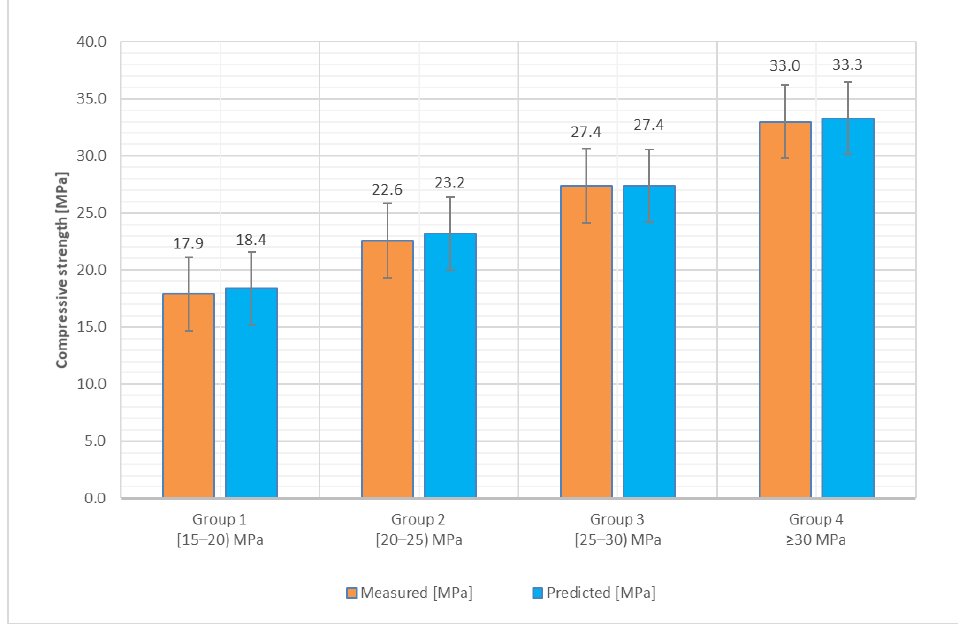
Figure 6. Compressive strength, mean values.